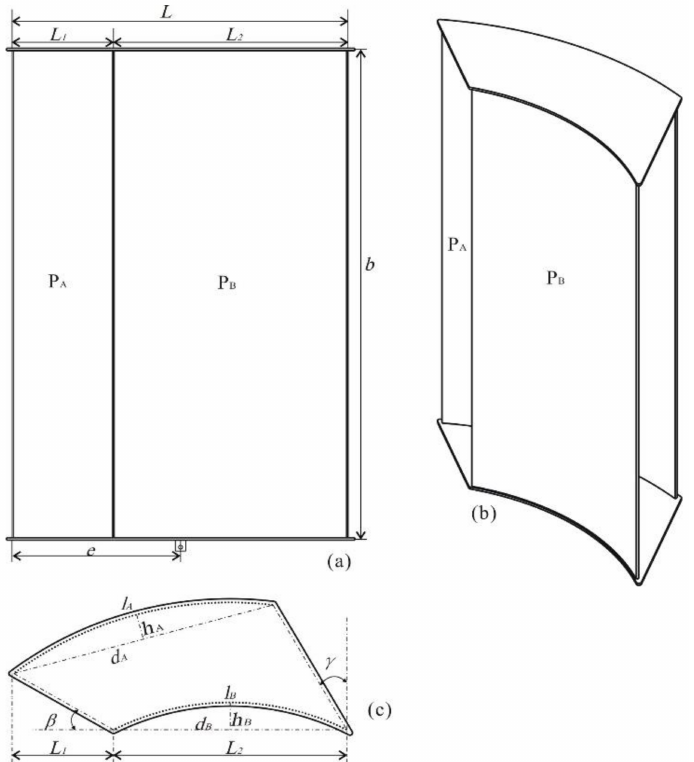
Figure 1. Structure and parameters of the otter board model. ( a ) Front view; ( b ) Configuration; ( c ) Top view. P A : rear wing; P B : fore wing; L : chord; b : span; l A , l B : arc lengths of panels; L 1 : projection length of the gap; L 2 : projection length of l B ; h A , h B : distances from the midpoint of the arc to the chord; d A , d B : chord lengths of panels; e : distance from the leading edge to the center pivot; β : front staggering angle (i.e., the angle formed by the fore wing chord and the line connecting with the left edge of both wings); γ : tail staggering angle (i.e., the angle formed by the line connecting with the right edge of both wings and a vertical line).